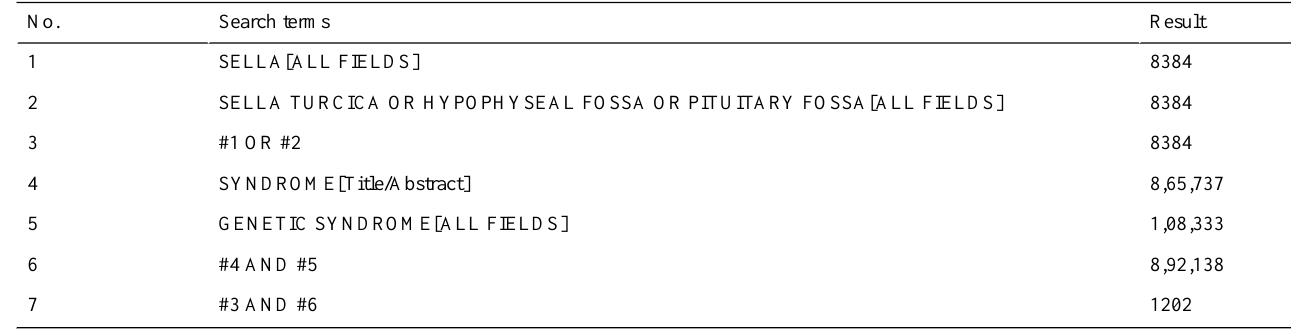
Table 1. Example of search strategy used in this review (Database: PubMed; Date: Sep 24, 2019; Limits: none). ResultSearch